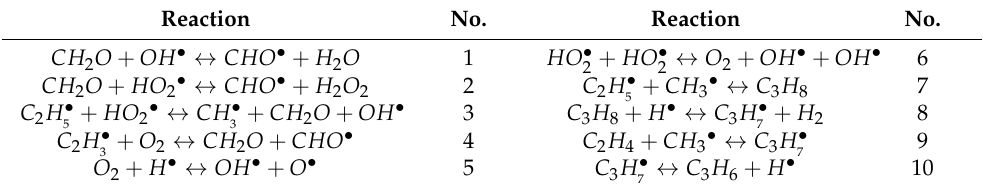
Table 3. Additional gas-phase reaction steps (in respect to Table 2), as proposed by Chen at al. [97], for describing OCM reactions in the absence of catalysts and under pressures up to 1000